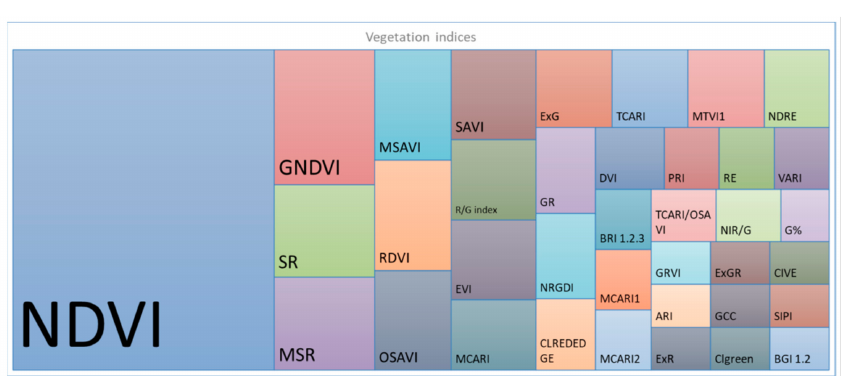
Figure 9. Vegetation indices usage with 3 or more references represented with proportional